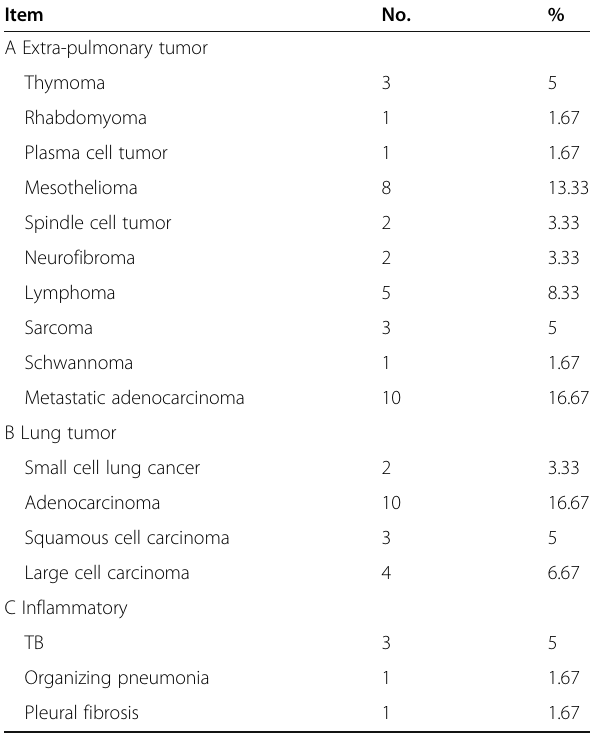
Table 9 Pathological diagnosis